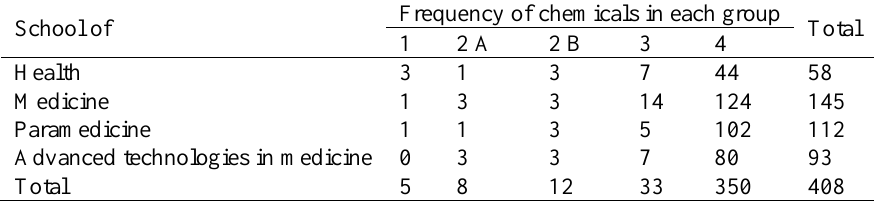
Table 1. Frequency of chemicals used in schools of Golestan University of Medical Sciences based on IARC guidelines